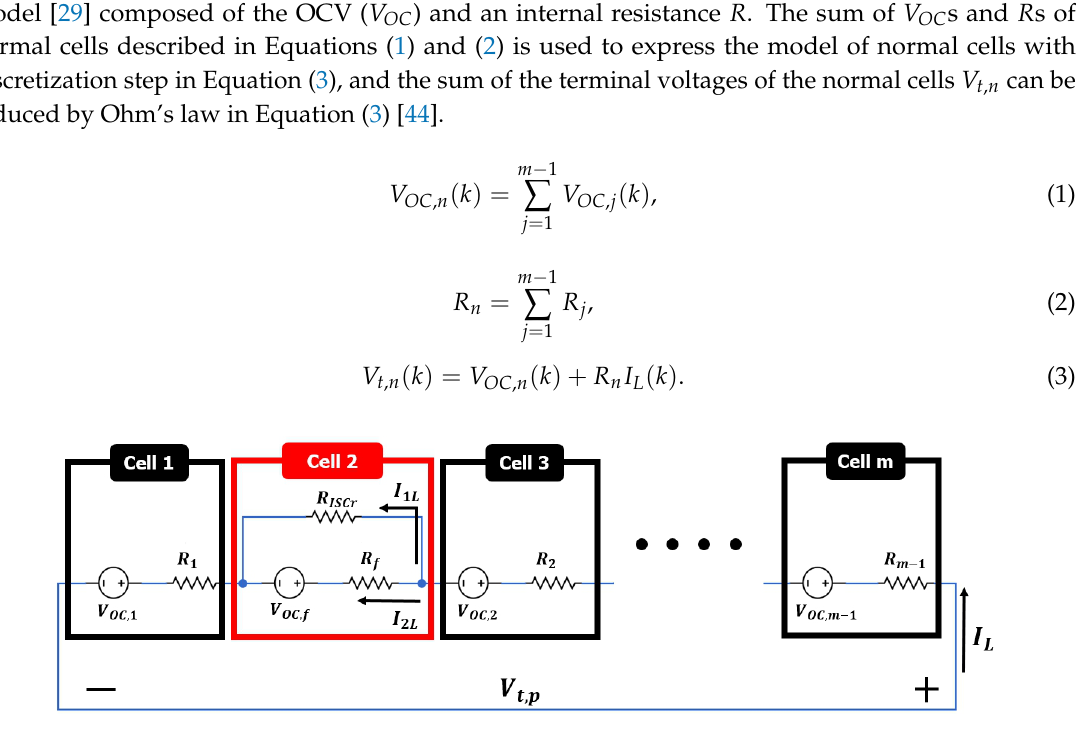
Figure 2. Equivalent circuit model of the lithium-ion battery pack with internal short circuit